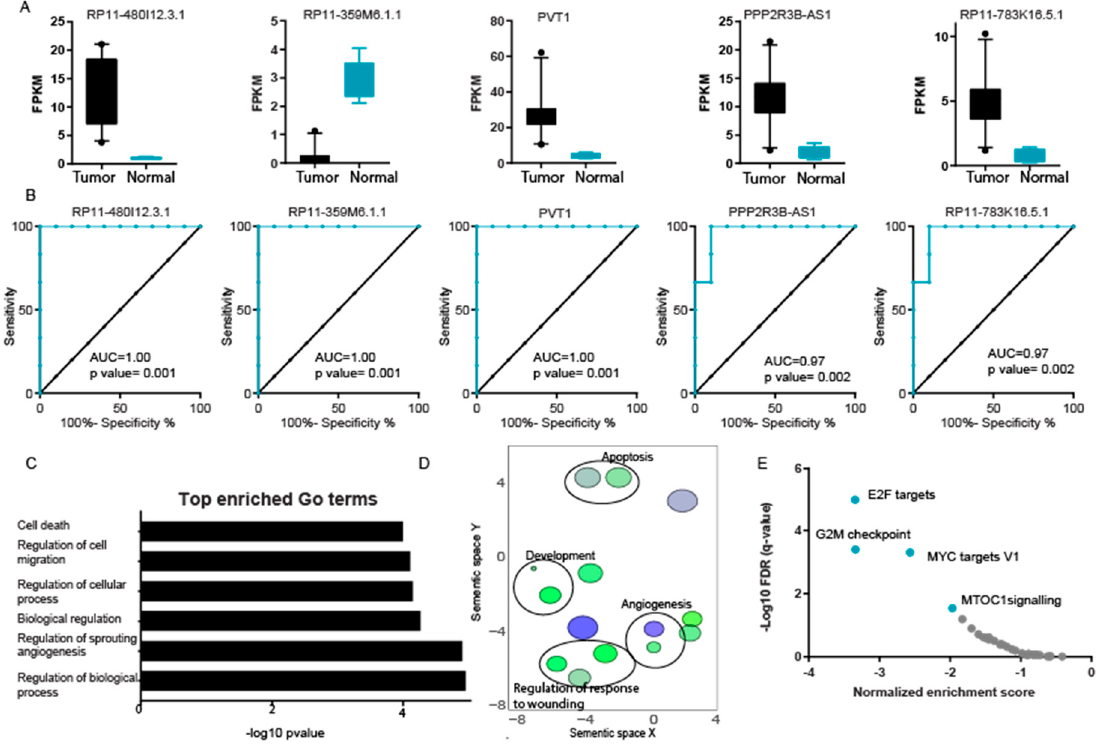
Figure 2. LncRNAs regulate signaling in LCLC. ( A ) The Box plot representing the expression level of indicated LncRNAs. The whiskers show the 10th and 90th percentile of expression. ( B ) Curve representing results of ROC analysis performed to show the sensitivity and specificity of mentioned LncRNA in LCLC vs. normal. ( C ) The bar diagram to show the significantly enriched Gene Ontology (GO) terms as identified in the GO analysis of best correlating genes. ( D ) Gene Ontology enrichment analysis for protein- coding genes co-expressed with differentially expressed lncRNAs with visualization by REViGO algorithm [10]. ( E ) Scatter plot showing significantly enriched data sets in Gene Set Enrichment Analysis (GSEA) using protein- coding genes co-expressed with differentially expressed lncRNAs [11].